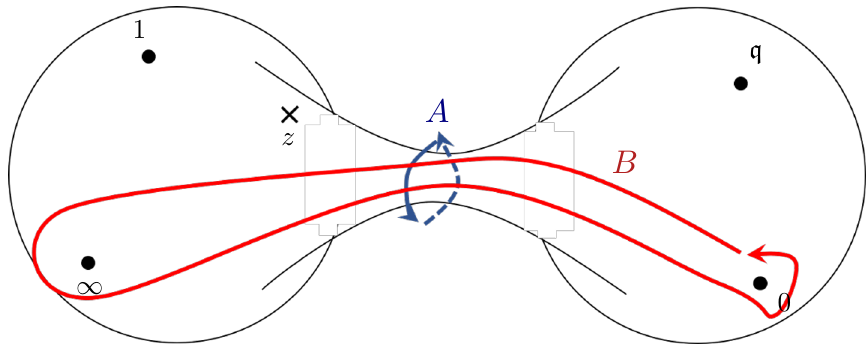
Figure 2 . The A -loop and the B -loop on the four-punctured sphere P 1 \{ 0 , q , 1 , ∞} . Here, z is the position of the apparent singularity, around which the monodromy of the associated Fuchsian system is trivial. The A -loop is depicted as the blue line, while the B -loop is drawn as the red